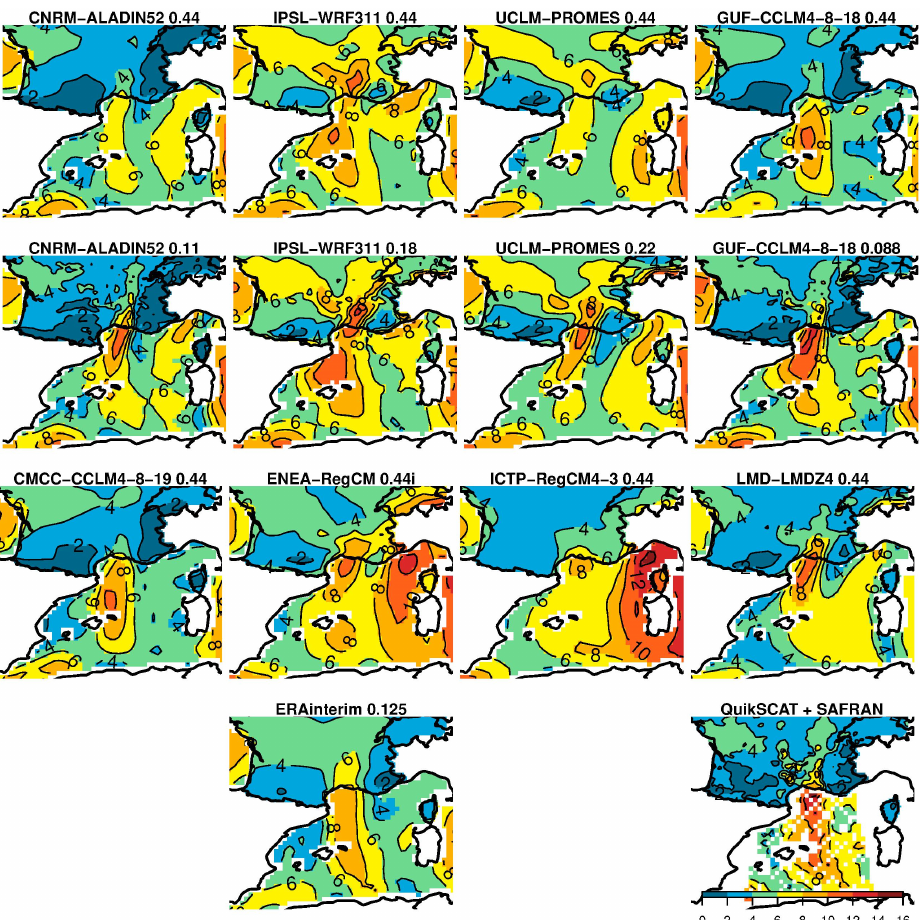
Figure 4. Daily mean 10 m surface wind speed (m/s) on 24 March 2002 obtained from Med-CORDEX RCMs [5], ERA-Interim [53], QuikSCAT [54], and SAFRAN [55,56]. The color scale in the last panel applies to all panels. Figure from